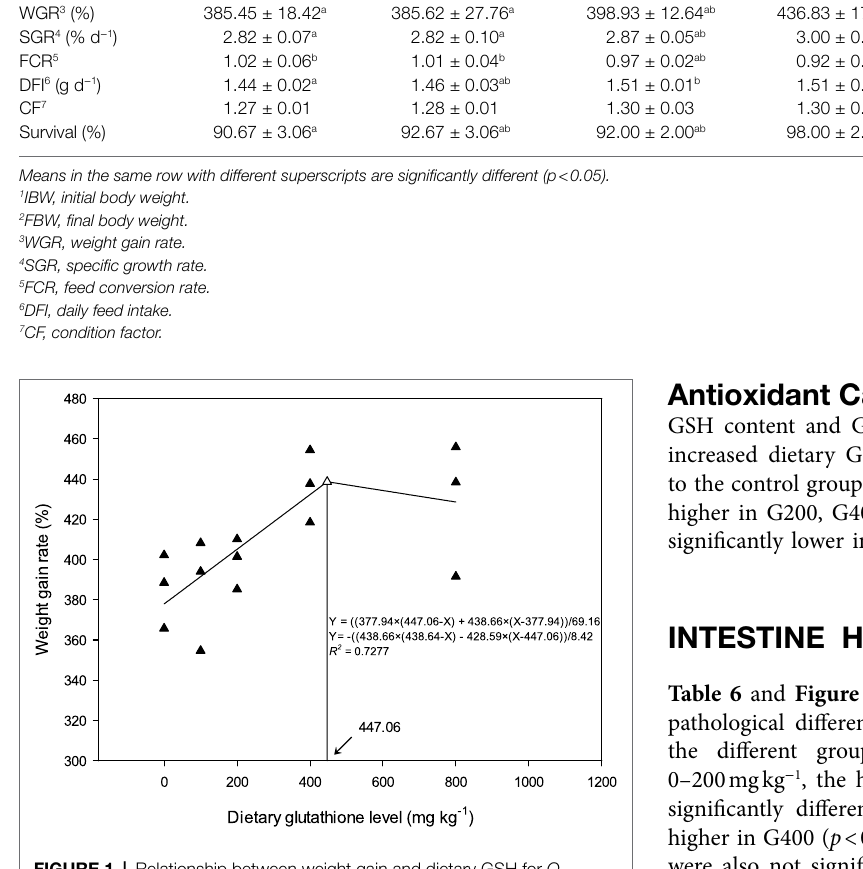
FIGURE 1 | Relationship between weight gain and dietary GSH for O. mykiss as described by a broken line regression ( n = 3). The breakpoint in the broken line is 447.06 mg kg − 1 .